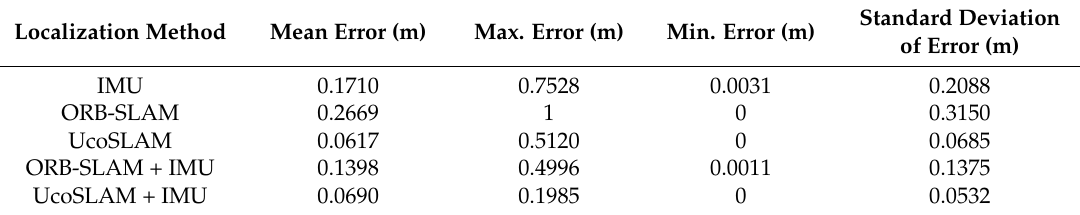
Table 2. Performance of different localization approaches.